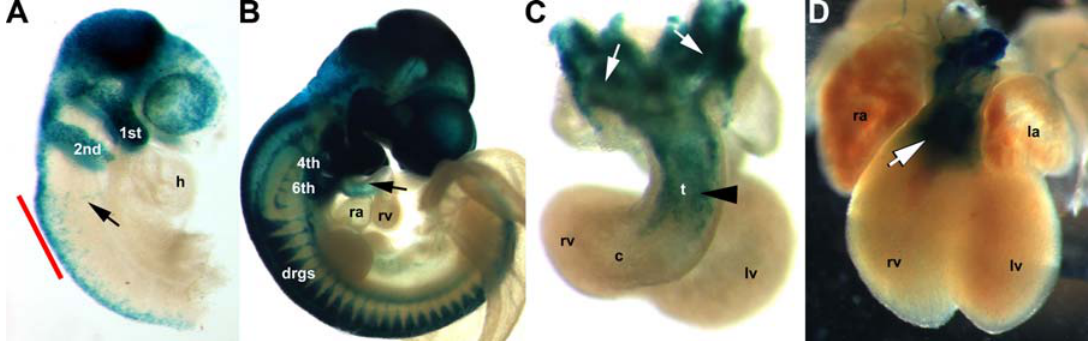
FIGURE 1. Specificity and efficiency of NC marking using the Wnt1-Cre [11] and R26R reporter Cre/loxP system. (A) Whole-mount staining of an E8.0 embryo. Labeling is seen in the dorsal neural tube, first and second pharyngeal arches (numbered), and migratory CNC (arrow). Location of CNC progenitors is indicated by red line. The OFT of the heart (h) is unlabeled, but is in obvious proximity to the pharyngeal arches. (B) Staining in an E11.0 embryo. Extensive labeling is seen in the head, dorsal neural tube, NC-derived dorsal root ganglia (drgs), all the pharyngeal arches (fourth and sixth numbered), and in CNC colonizing the OFT of the heart (arrow). (C) Isolated E11.0 heart. LcZ labeling can be seen in the aortic arch arteries (white arrows) and the truncus (t) of the OFT cushions (large arrowhead), but not in the conus (c). (D) E14 mature septated heart. Note robust lacZ reporter staining is present in the condensed mesenchyme of the OFT conus (arrow) and the anterior divided truncus, but is absent from the ventricles and atria. Abbreviations: rv, right ventricle; lv, left ventricle; ra, right atria; la, left